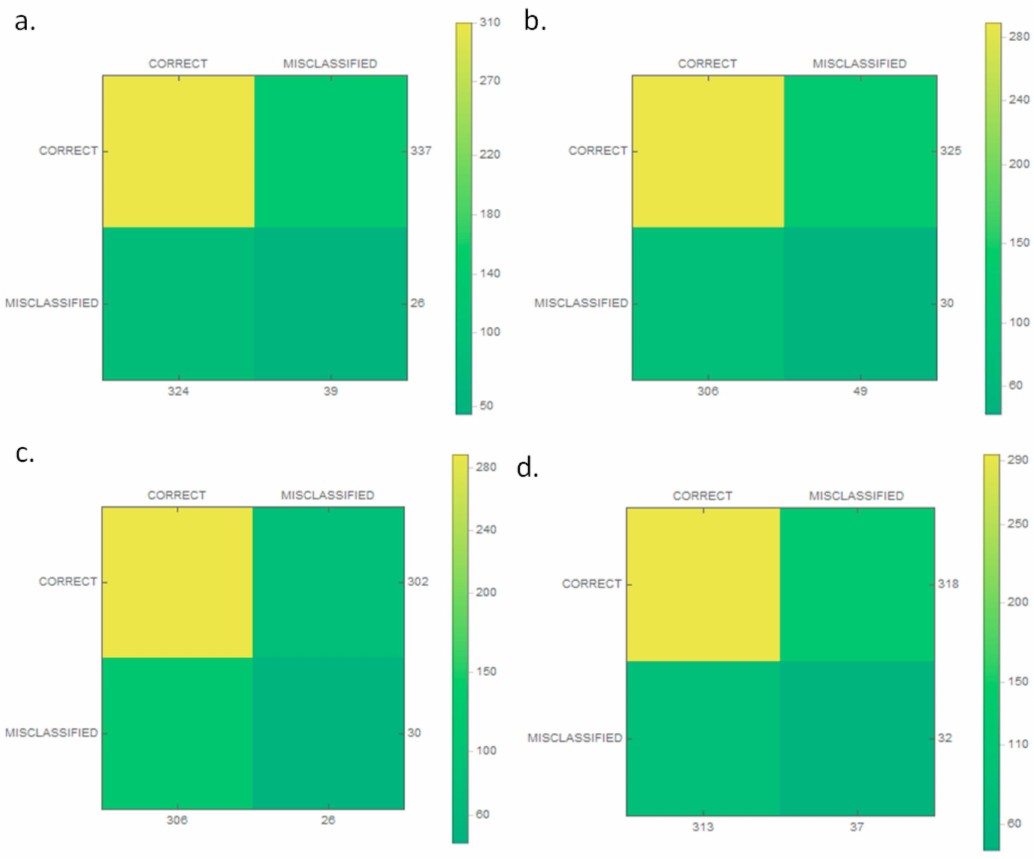
Figure 6. The confusion matrices of the classification model for each class: ( a ) boat; ( b ) motor yacht; ( c ) navy ship; and ( d ) historic ship.